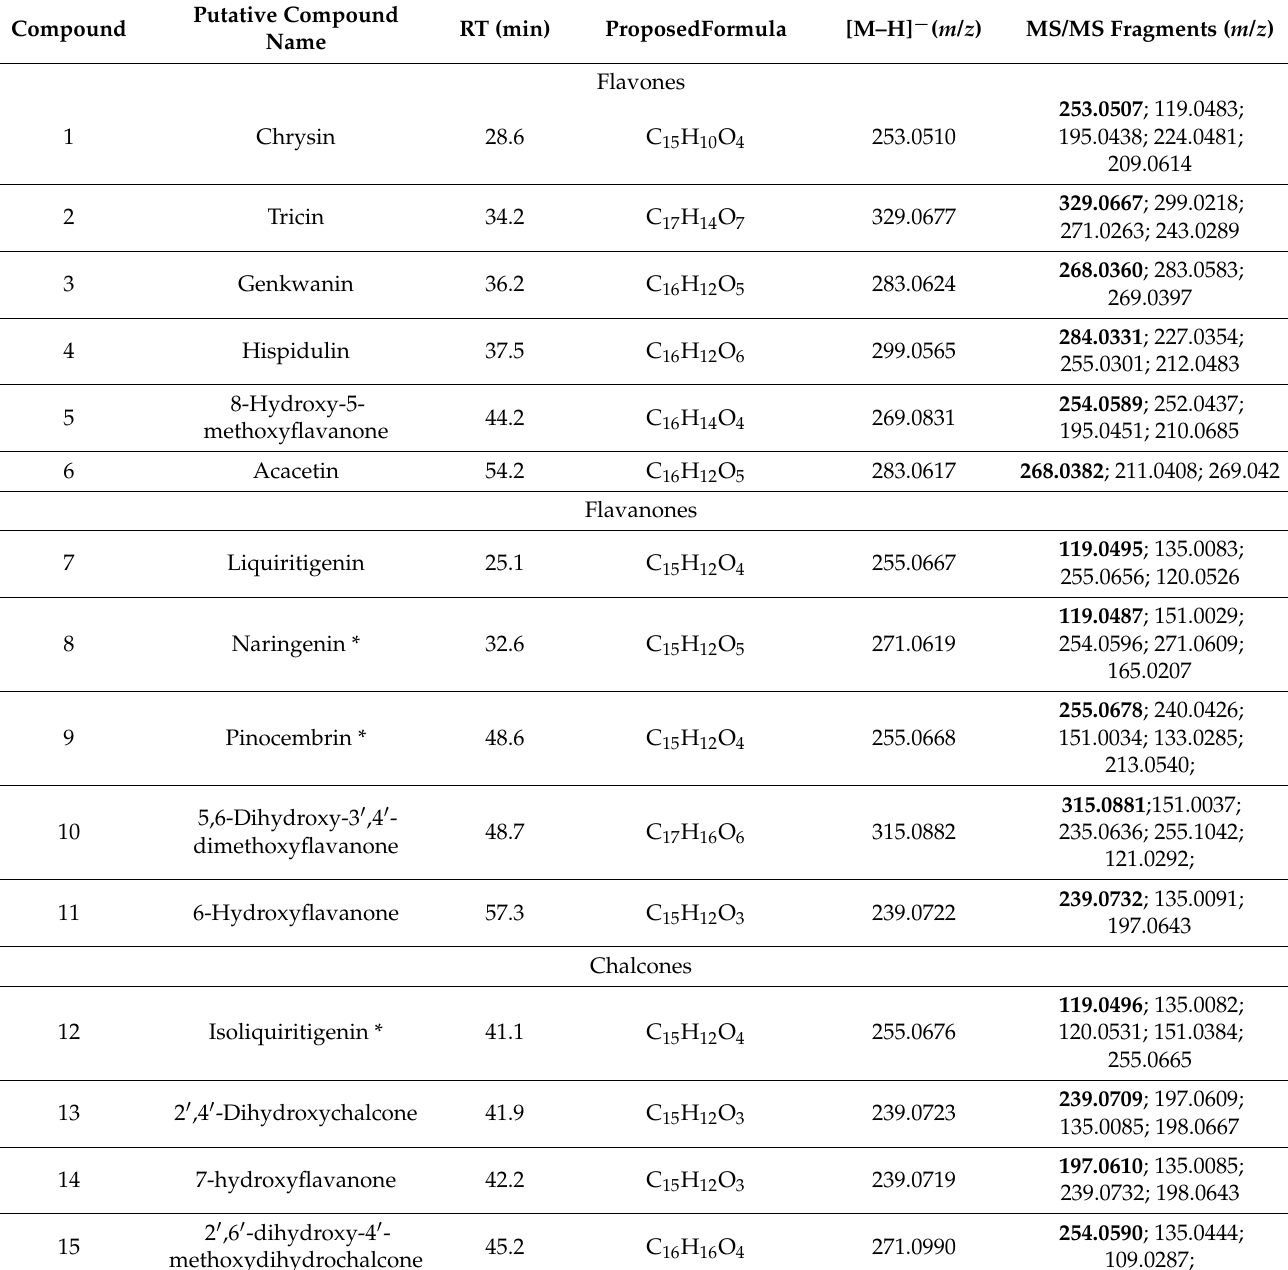
Table 3. LC-ESI-QTOF-MS/MS analysis of phenolic compounds present in Brazilian red